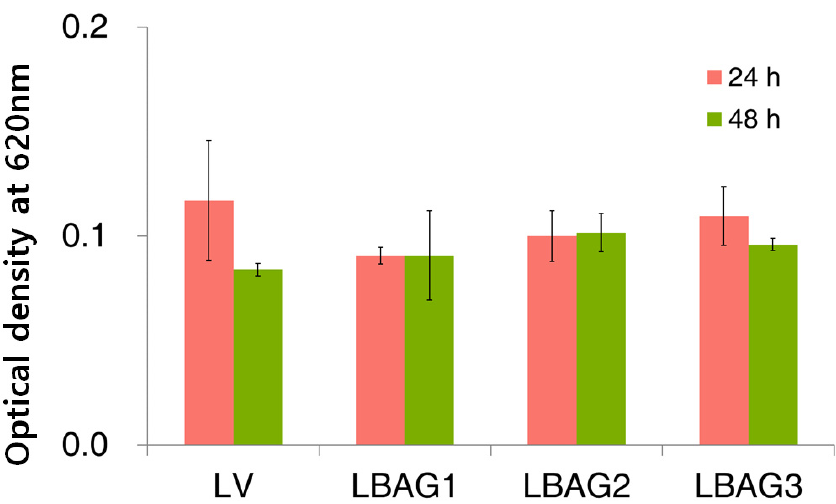
Figure 7. Cell viability results (after 24 and 48 h) using HGF-1 cytotoxicity on LV and FBAG-resin disk. The one-way ANOVA was used to compare the cell viabilities within groups for 24 h and 48 h (p > 0.05). Error bars represent ± standard error.